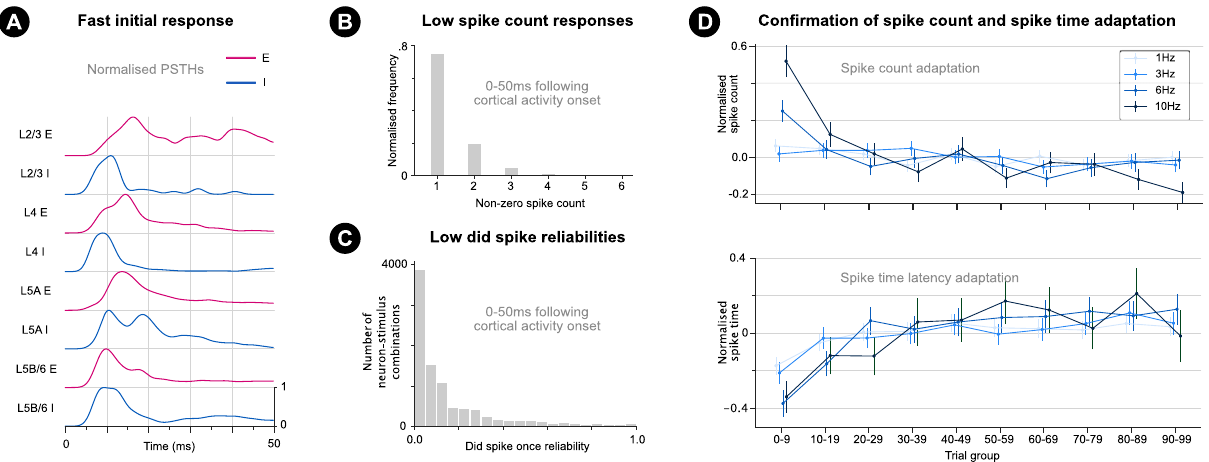
Figure 2. Properties of initial responses of cortical neurons to sensory stimulation. ( a ) Max normalised post- stimulus time histograms (PSTHs) over a 50ms window following stimulus onset (averaged over all trials) for all 8 neuron groups (excitatory in red, inhibitory in blue) in different cortical layers (L) and a 1Hz stimulus. Smoothed with a Gaussian kernel ( σ = 1.5 ms). ( b ) Normalised spike count histogram over all neurons, trials and stimuli (over 50 ms following cortical activity onset). Zero spike trials are not included. ( c ) Histogram of single neuron single stimulus condition did spike once reliabilities. Each value represents the proportion of trials of a stimulus condition that a single neuron spiked at least once. ( d ) The effect of adaptation over trials (by stimulus-frequency). Top: For each single neuron and stimulus condition combination, spike counts are normalised (mean subtracted followed by division by standard deviation). Means of these normalised spike counts (over single neuron and stimulus condition combinations) are then calculated for stimulation frequency groups (0–0.2, 1, ..., 10 Hz) and 10 trial bins (i.e. trials 0–9, ..., 90–99). These mean values are plotted with a 95% confidence interval ( ± 2 σ ) for stimulation frequencies 1, 3, 6, 10 Hz here and the remaining frequencies in Supplementary Fig. 1. Bottom: Same as for spike counts (top) but for normalised first spike times. Data for remaining frequencies shown in Supplementary Fig.